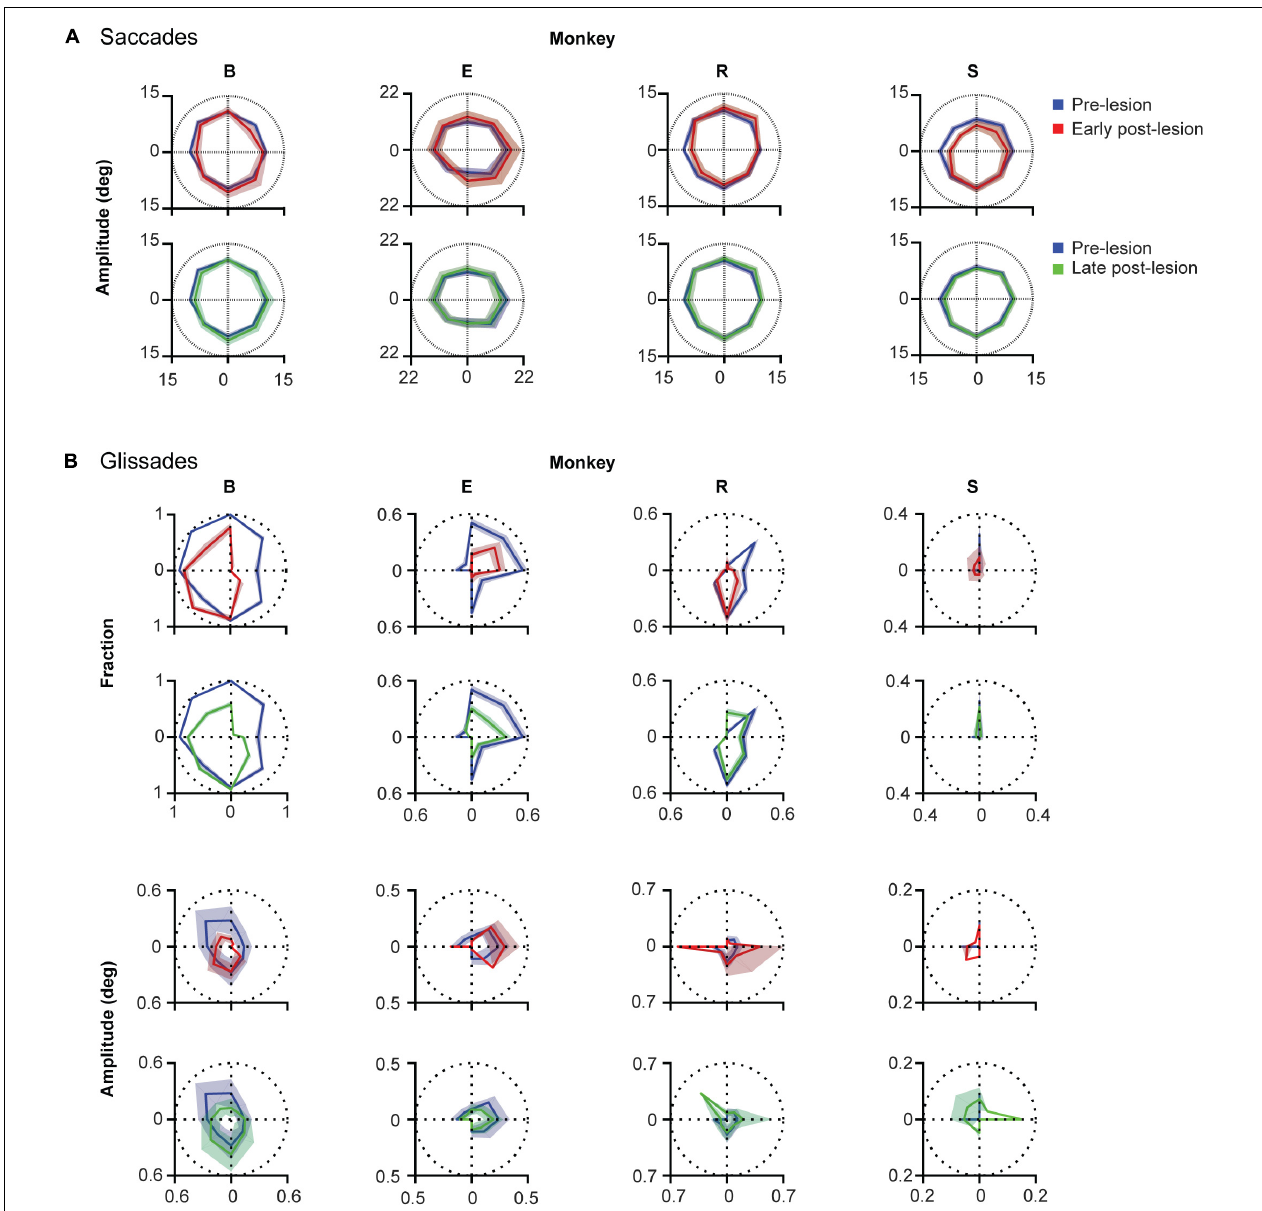
FIGURE 7 | Direction specificity of lesion phenotype for glissades and saccades sorted for saccade direction. (A) Effect of lesion on saccade amplitude in different directions. Blue lines represent pre-lesion condition, red lines represent early post-lesion condition and green lines represent late post-lesion condition. (B) Top two rows show fractions of saccade with a glissade sorted for saccades in each of the eight cardinal directions. Shading of fractions represent Jeffrey’s interval. Bottom two rows show average glissade amplitude for saccades in each of the eight cardinal directions. Shading of amplitudes plots represent one standard deviation. Only overshooting glissades were used for this analysis. See Supplementary Table 5 for p -values and correlation coefficients between lesion time epochs. Labels “B,” “E,” “R,” and “S” denote each of the four